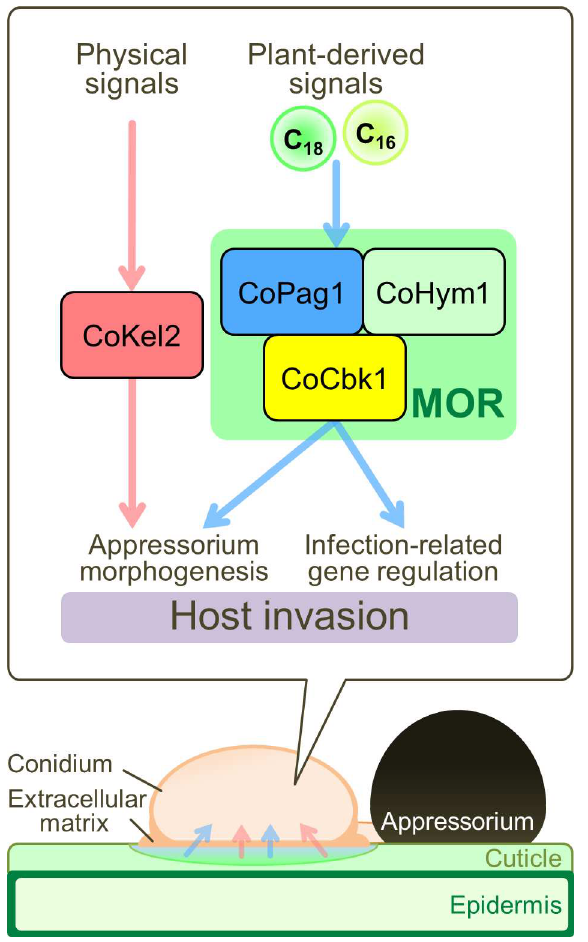
Fig 7. Model for appressorium-mediated invasion of C . orbiculare in responseto plant-derivedsignals. Esteraseactivity in the extracellular matrix of conidiafrees the cutin monomer n -octadecanal (C 18 ) from plant surfacecutin to serve as the signalmoleculefor appressorium development via the MOR components of C . orbiculare